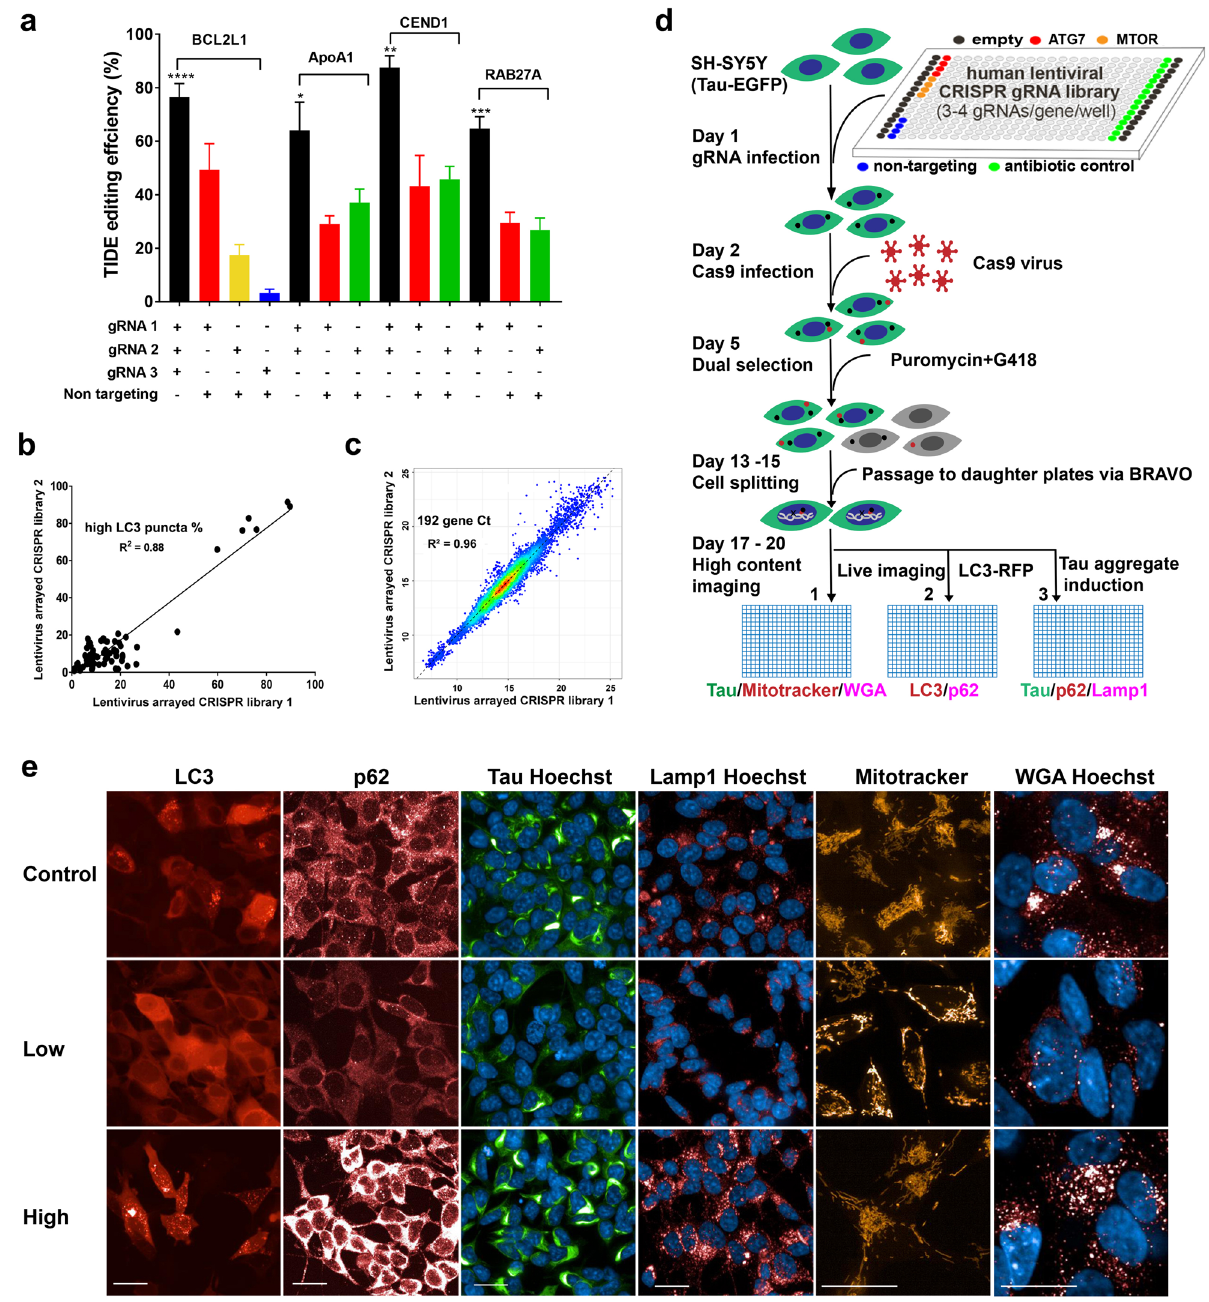
Figure 1. Multi-modal arrayed CRISPR and HCI phenotypic screen development. ( a ) Multiplexing lentiviral gRNAs significantly increased editing efficiency compared to single guides. Total lentivirus volume was fixed, n = 4, one-way ANOVA was applied to compare gRNAs performances in each gene group, * p -value < 0.05 ( p = 0.016), ** p -value < 0.01 ( p = 0.004), *** p -value < 0.001, **** p -value < 0.0001. ( b ) Pilot CRISPR screen with two batches of lentiviral gRNA preparation reveals significantly correlated functional phenotype—percentage of cells high in LC3 puncta. R 2 = 0.88, p -value < 0.0001. ( c ) qPCR analysis of 192 genes resulting from pilot CRISPR screen show highly correlated expression indicated by Ct values. R 2 = 0.96, p -value < 0.0001. ( d ) Automated 384-well arrayed CRISPR and HCI screen workflow. ( e ) Representative confocal images of screen phenotypes, highlighting low and high signals in number of puncta, signal intensity, spectrum of morphology for each readout respectively, scale bar = 10